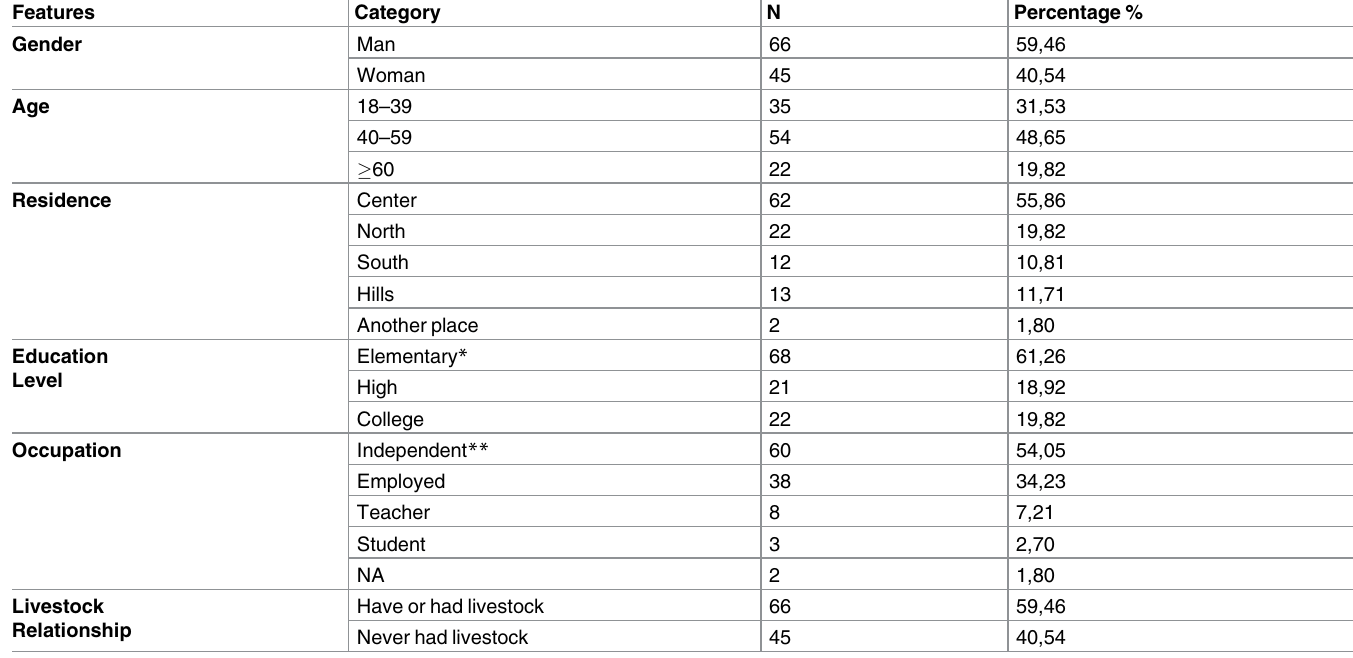
Table 2. Demographics of